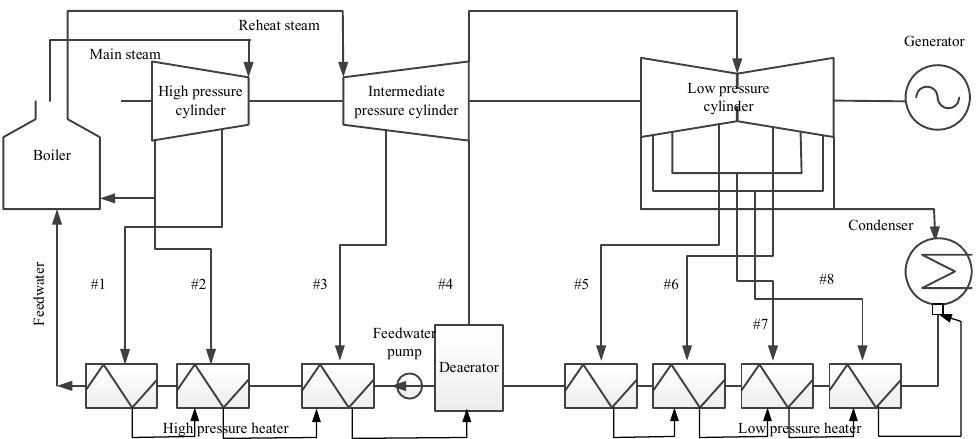
Figure 1. Thermodynamic system diagram of condensing steam turbine.